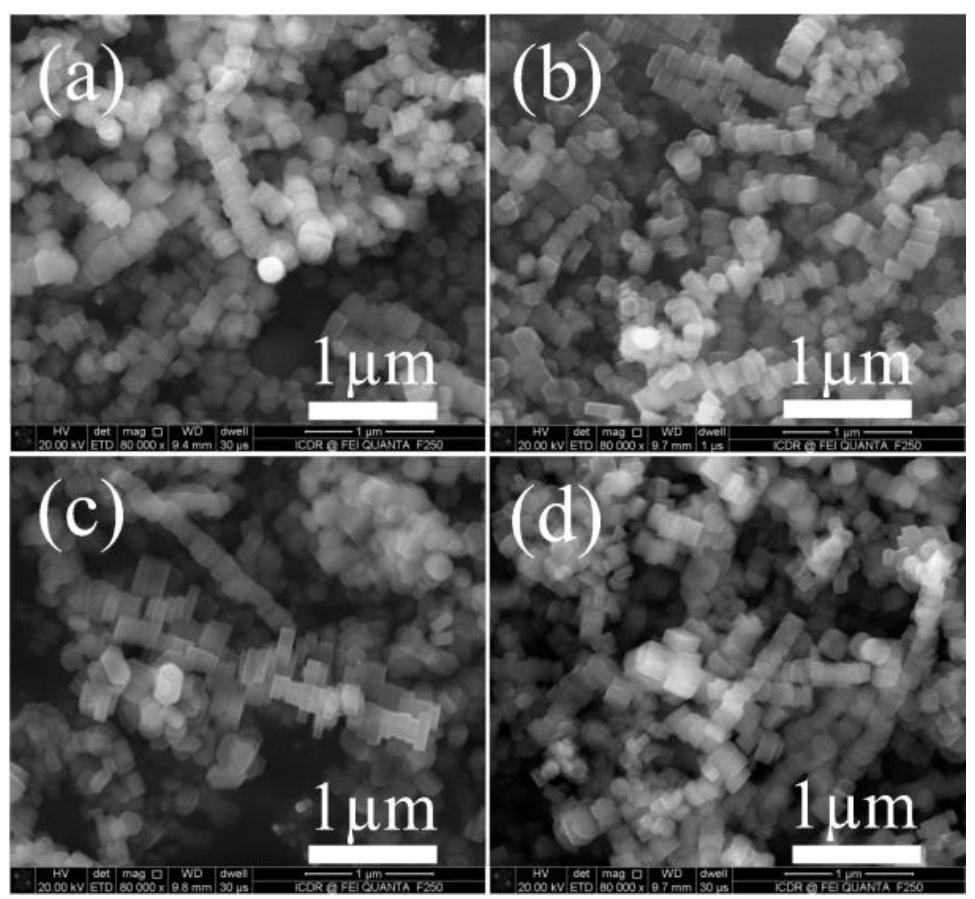
Figure 9. SEM images of ZSM-5 zeolite prepared with different alcohols in the synthesis gel. ( a ) Figure9. SEMimagesofZSM-5zeolitepreparedwithdi ff erentalcoholsinthesynthesisgel. ( a )methanol; methanol; ( b ) ethanol; ( c ) ethylene glycol; ( d ) isopropanol. ( b ) ethanol; ( c ) ethylene glycol; ( d )